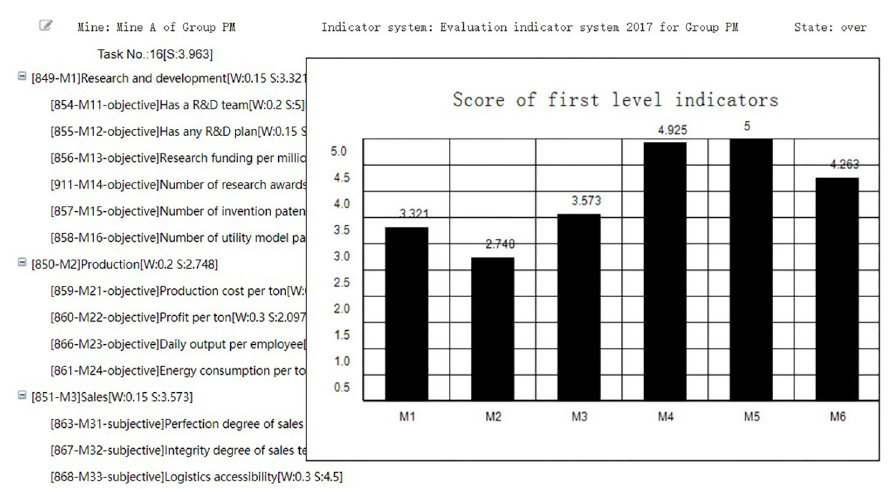
Fig 19. Score evaluation result.